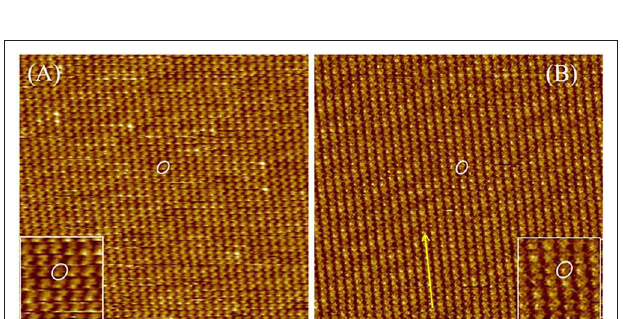
I set = 70pA, V bias = − 750mV; (B) I set = 70pA, V bias = − 750mV. The graphite symmetry axes are shown in red. The yellow lines indicate the directions of the unit-cell vectors. (C,D) Tentative molecular packing models corresponding to the STM images. Hydrogen bonds are indicated by white dotted